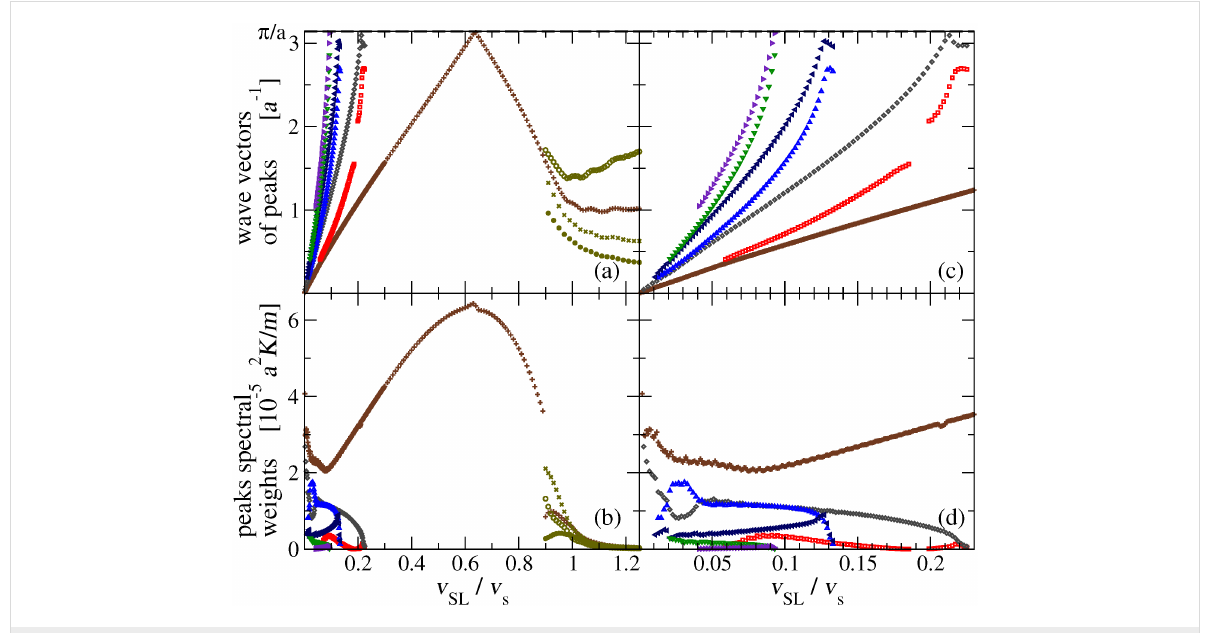
Figure 10: The positions (a) and heights (b) of the peaks of as functions of v SL . Panels (c) and (d): detail of the v SL ≤ 0.23 v s low-speed region for the same quantities.